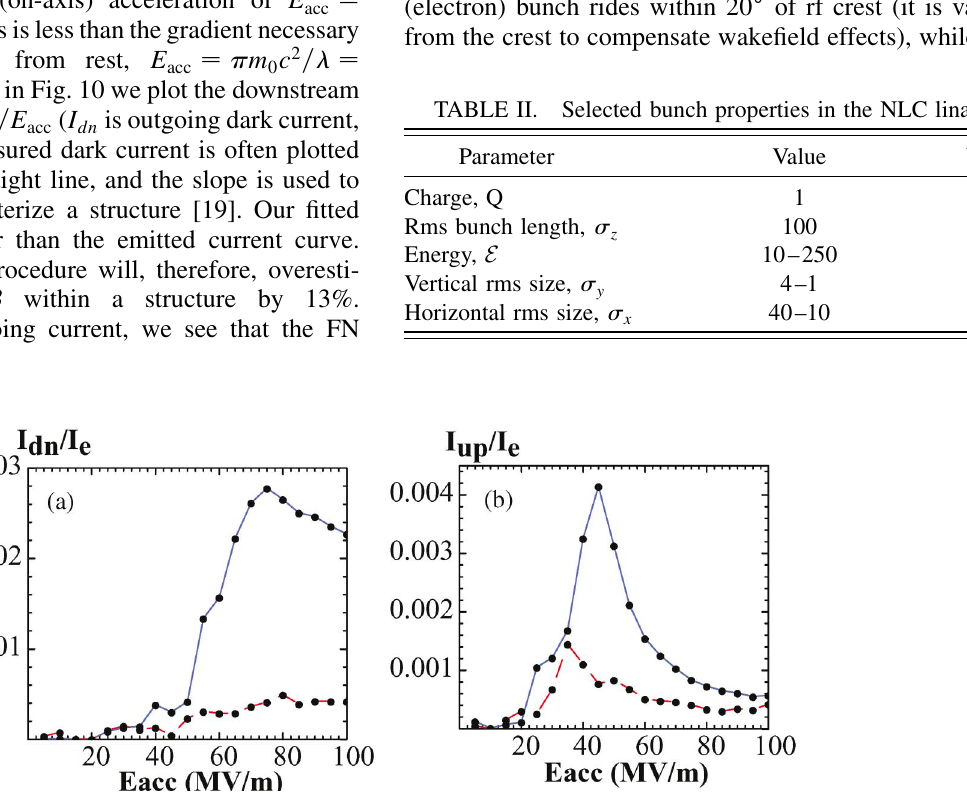
FIG. 9. (Color) Gradient dependence of fraction of emitted current reaching downstream (a) and upstream (b) detectors, for uniform (solid line), nonuniform (dashes)